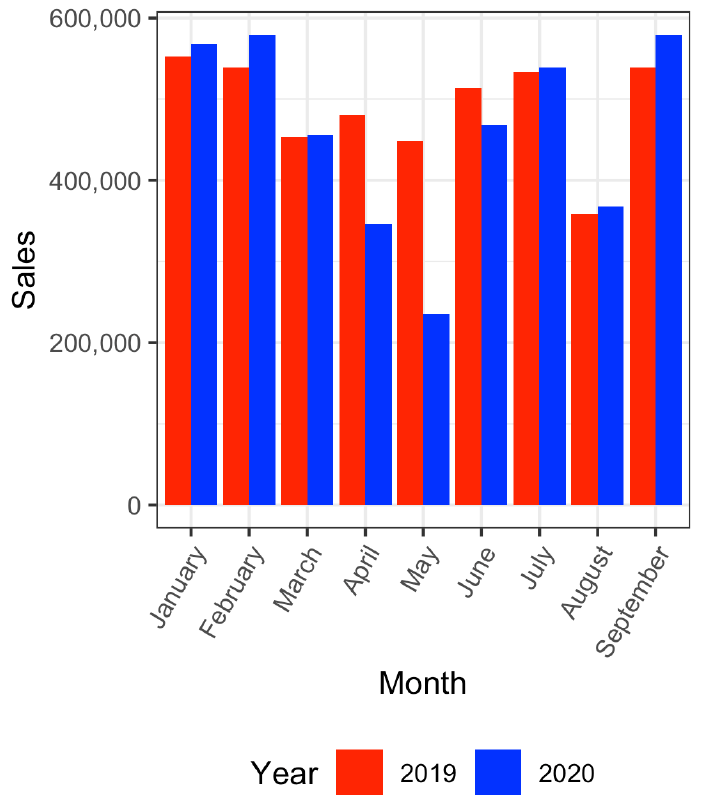
Figure 3. Changes in the overall sales volume for phosphodiesterase type 5 inhibitors between 2019 and 2020 (January–September for both years).